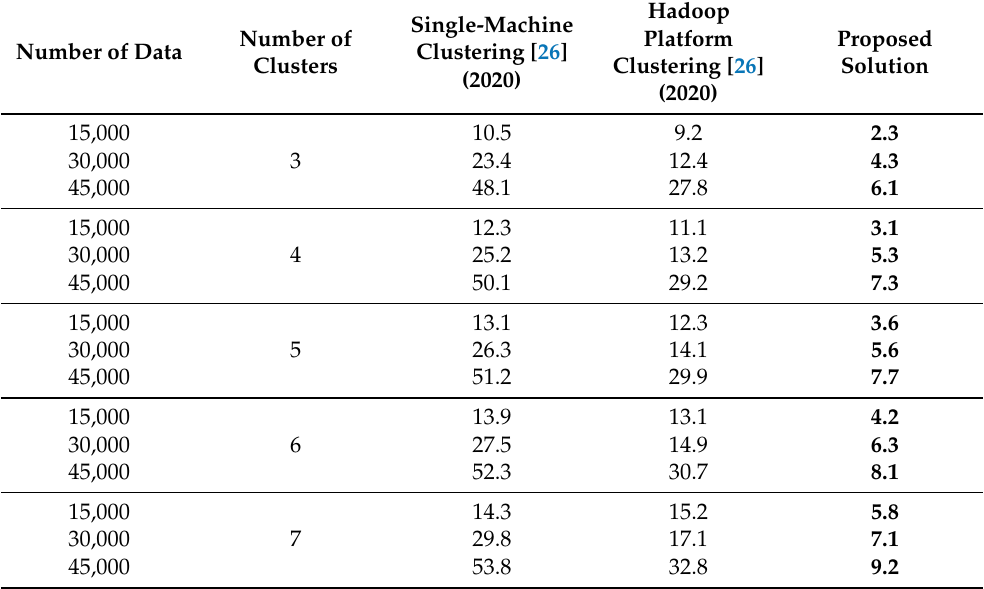
Table 9. Time elapsed for k clusters in